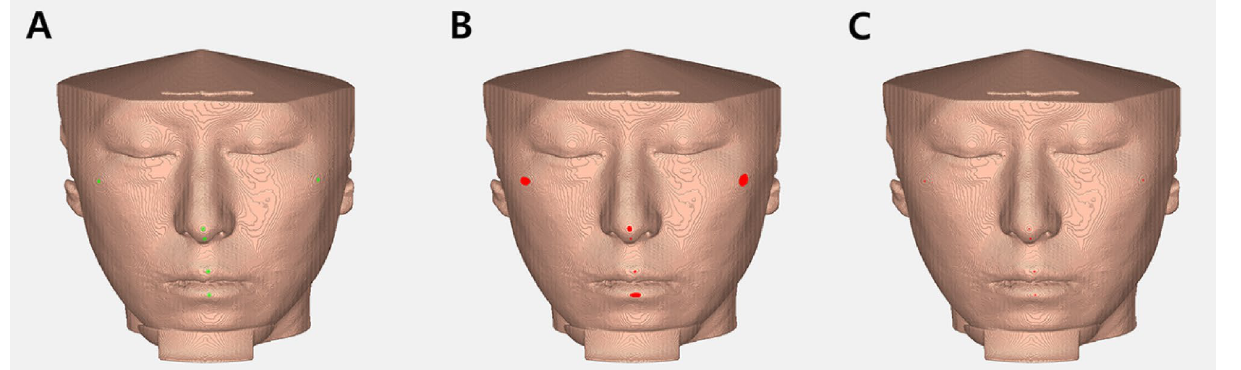
Figure 3. The process of obtaining the CC points of all the soft tissue landmarks (Full face view). ( A ) Manual coordinate determination of six landmarks (green dots). ( B ) Tabletop area (red area) including the coordinates of the starting points taken manually. ( C ) Average coordinates of the points (CC point, red dots) on the tabletop plane